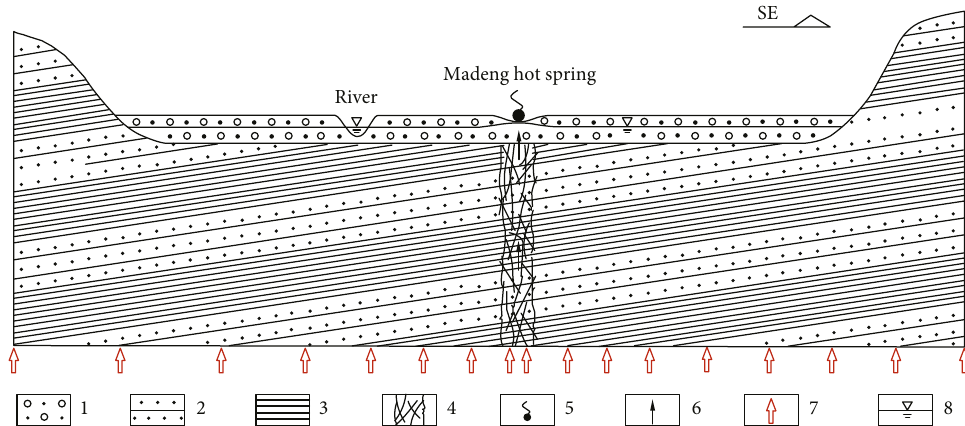
Figure 7: Schematic pro fi le showing the formation (near the vent) of the Madeng hot spring in Jianchuan county, Yunnan. 1 — sand and gravel; 2 — sandstone; 3 — mudstone; 4 — fracture zone; 5 — hot spring; 6 — thermal ground water fl ow; 7 — heat fl ow; 8 — water